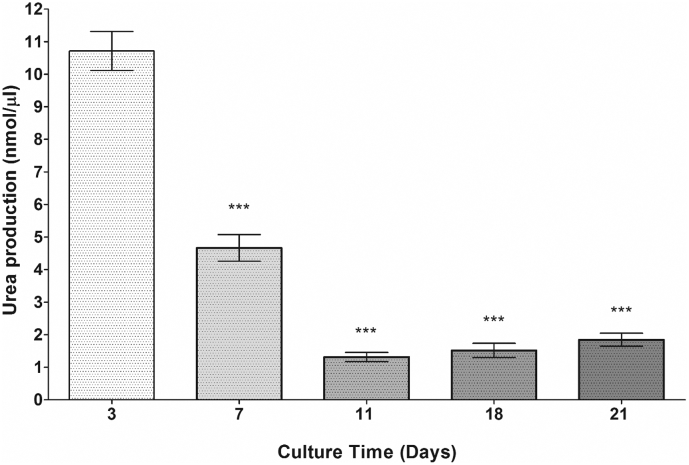
Urea synthesis analysis from 5000-cell spheroids. Spheroids were produced from on liquid-overlay plates. Urea secretion was quantified in 5000-cell spheroid supernatant samples over a 21 day culture period. Data are represented as mean ± SEM (n = 3 in triplicate). Urea synthesis was considered statistically significantly lower for all other time points compared to day 3 by One-way ANOVA, ⁎⁎⁎p < .001.